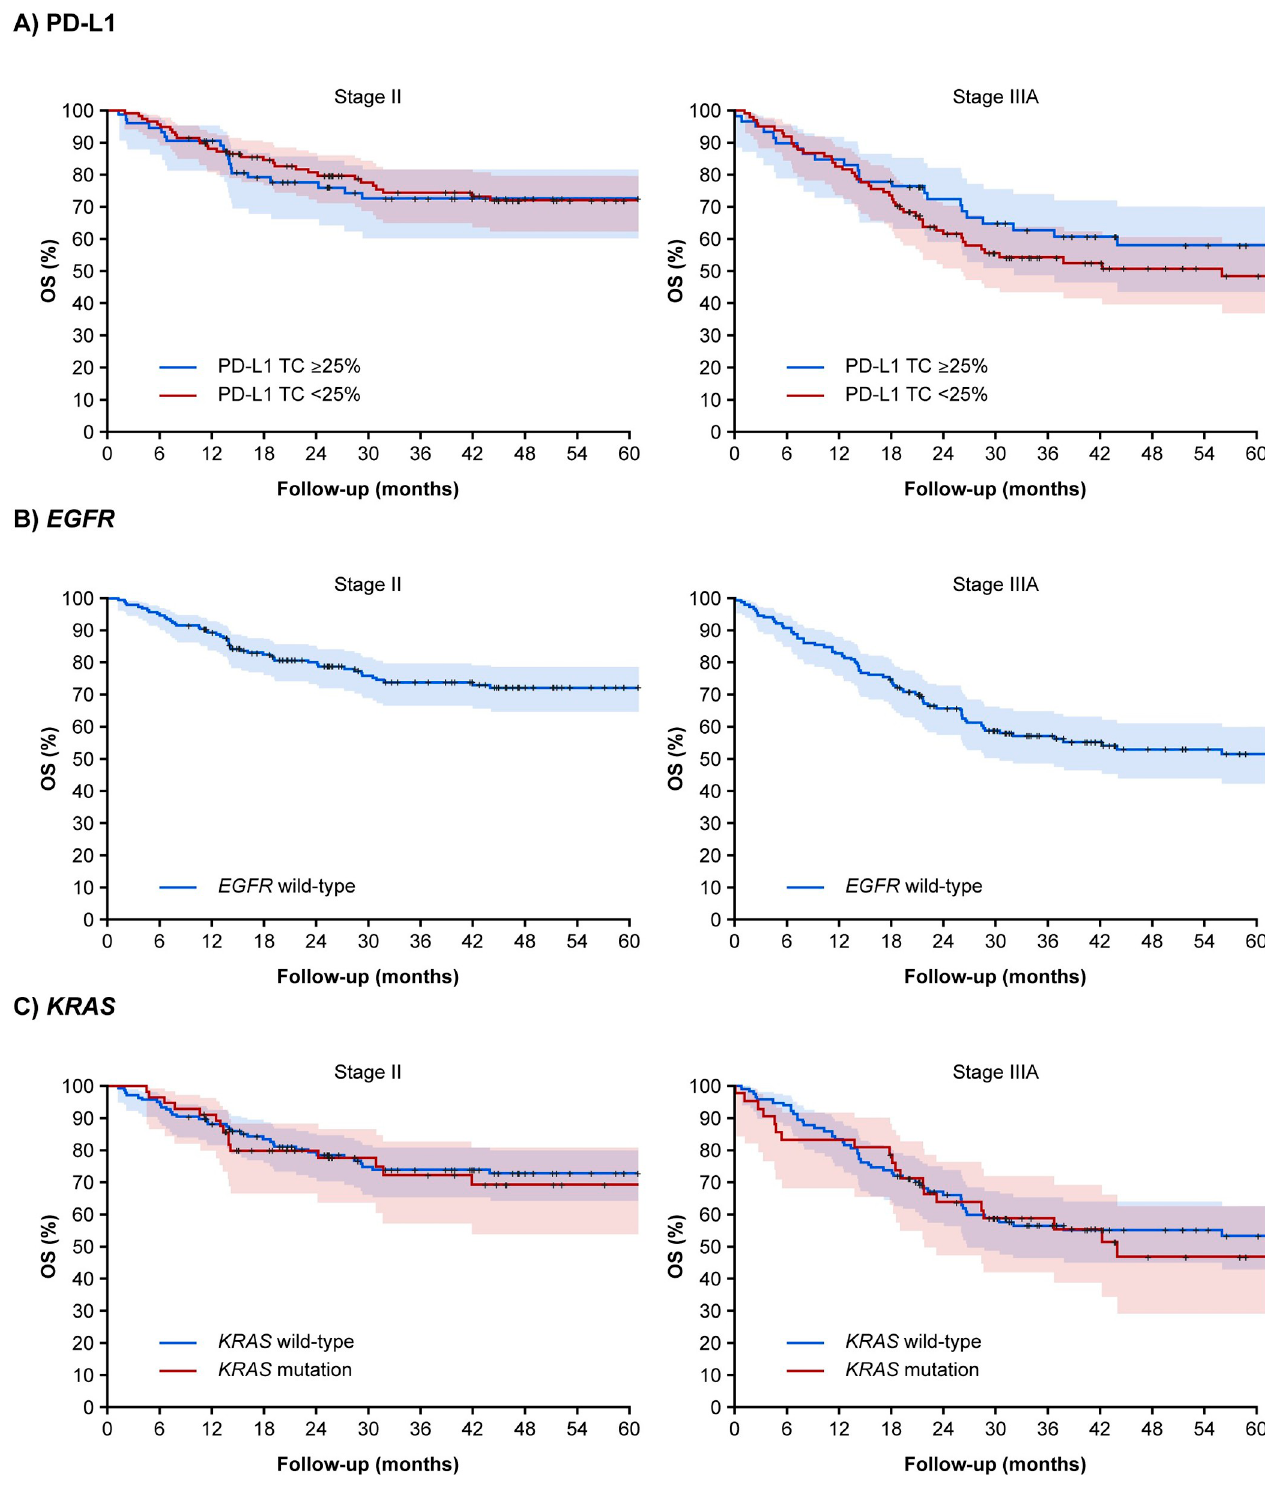
Fig 2. Kaplan-Meier curves for OS in patients with stage II and stage IIIA NSCLC receiving adjuvant chemotherapy according to PD-L1 expression (A), EGFR mutation status (B) and KRAS mutation status (C). a Neither the survival estimate nor the upper confidence limit reached the 50 th percentile. CI, confidence interval; EGFR , epidermal growth factor receptor; KRAS , V-Ki-Ras2 Kirsten rat sarcoma; NR, not reached; NSCLC, non-small cell lung cancer; OS, overall survival; PD-L1, programmed cell death ligand-1; TC, tumor cell.